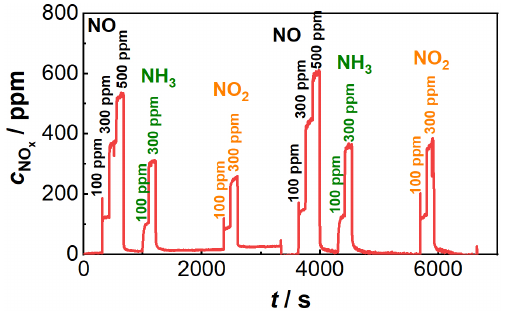
Figure 8. Resulting sensor signal after application of the charac- teristic curve correction; sensor temperature: 650 ◦ C; concentra- tions of the dosed gases NO (100, 300, 500ppm), NO 2 (100ppm, 300pm), and NH 3 (100ppm, 300pm) added in the diagram; com- position 1: 15% O 2 , 3% CO 2 , 3% H 2 O balanced by N 2 until 3700s; composition 2: 5% O 2 , 8% CO 2 , 8% H 2 O balanced by N 2 after